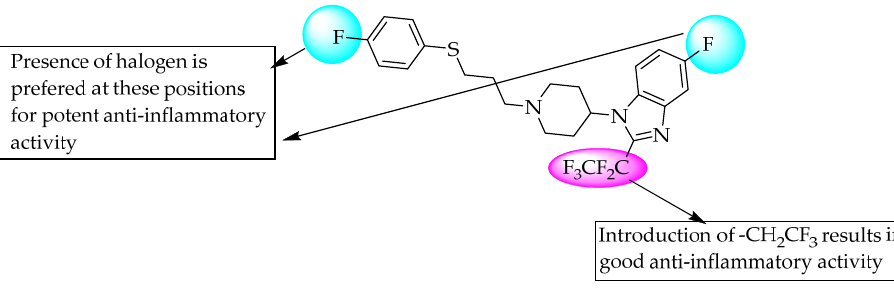
Figure 13. Benzimidazol-2-one compounds bearing five positions with substituted imidazole.